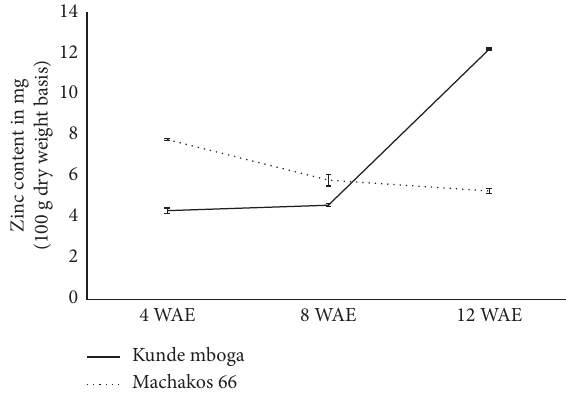
Figure 2: Efect of the interaction between crop variety and weeks after emergence (WAE) on the zinc content of the leaves. Te error bars indicate standard error of the